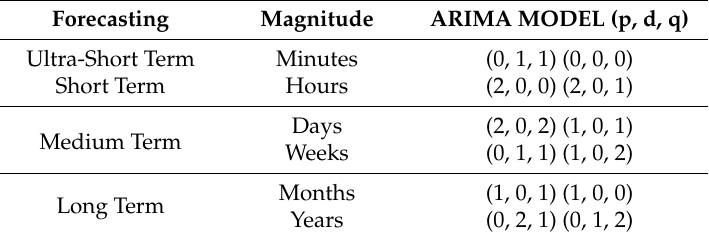
Table 2. ARIMA model for each horizon.